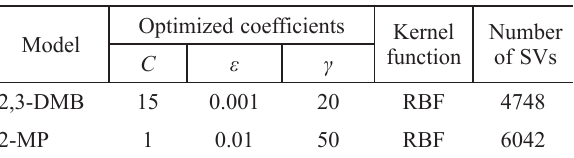
Table 12 – Comparison between 2,3-DMB and 2-MP SVM models